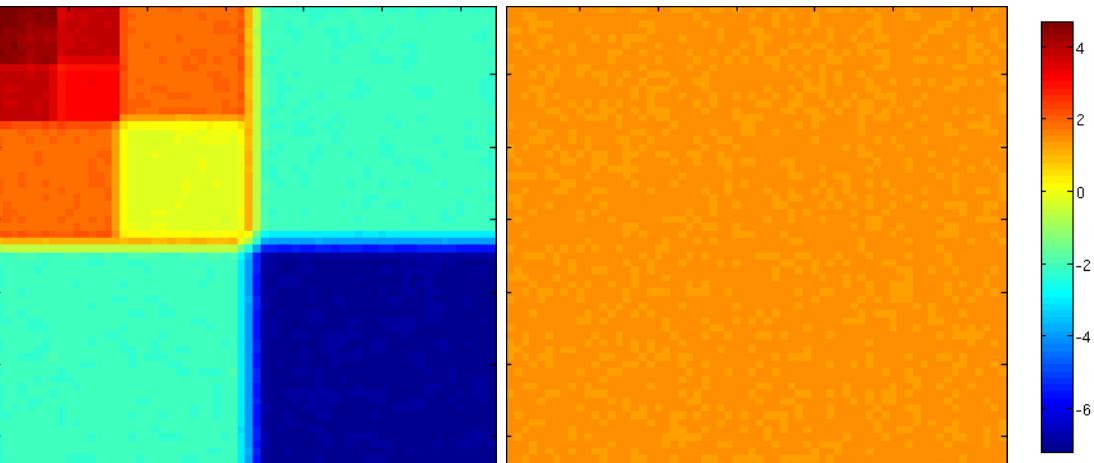
Figure 3. Logarithm of the variances of a correlated ( left ) and an uncorrelated ( right ) noise in the Figure 5.7 – Ces images présentent le logarithme de la variance estimés dans une base d’onde- wavelet space. One can see that approximation coefficients (for a correlated noise) have a very small lettes. A gauche, la variance est estiméee pour un bruit corrélé en espace. Un tirage de ce bruit variance while approximation coefficients have a large variance. When no correlation exists in the est présenté en figure 5.6. A droite, la variance est estimée pour un bruit décorrélé en espace. noise, all the coefficients have the same variance (which is one in this